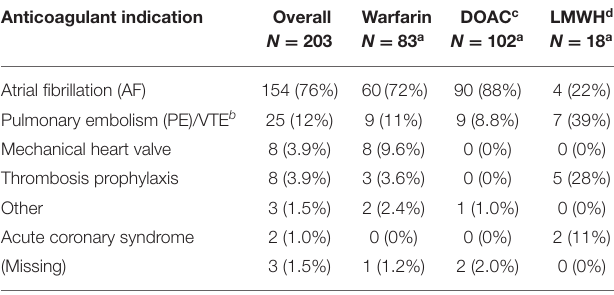
TABLE 4 | Indications for the use of